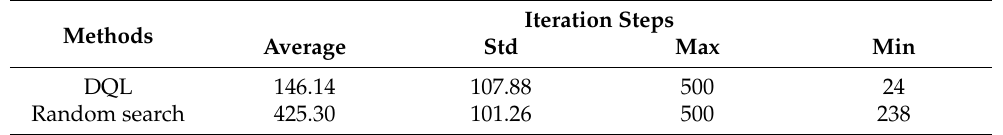
Table 1. Iteration steps taken to convergence for each method.